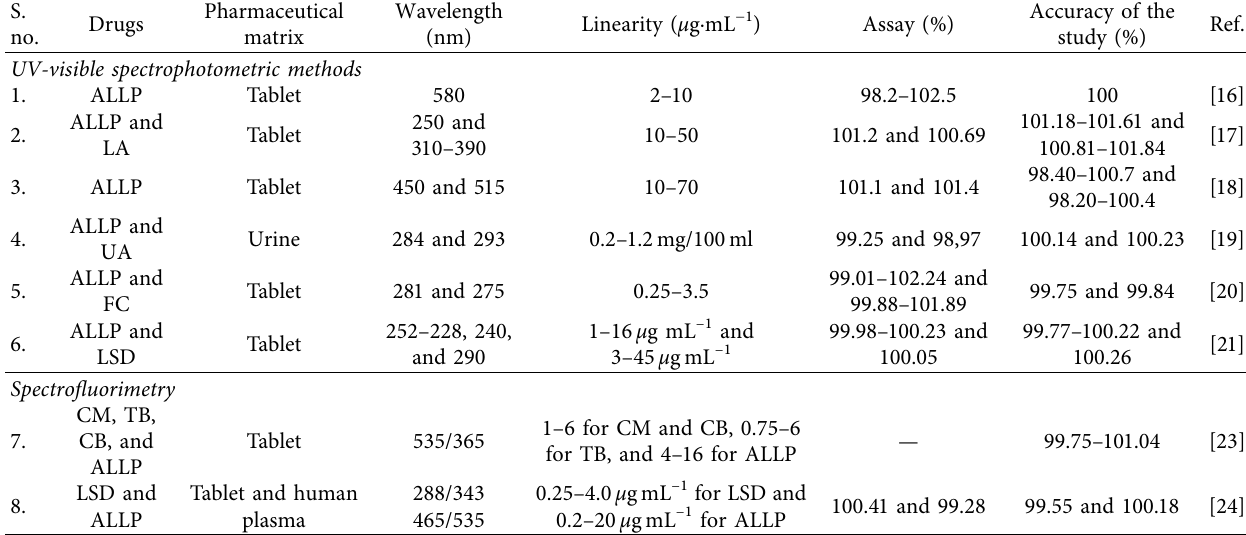
Table 1: UV-visible and spectrofluorimetric methods for the determination of allopurinol.